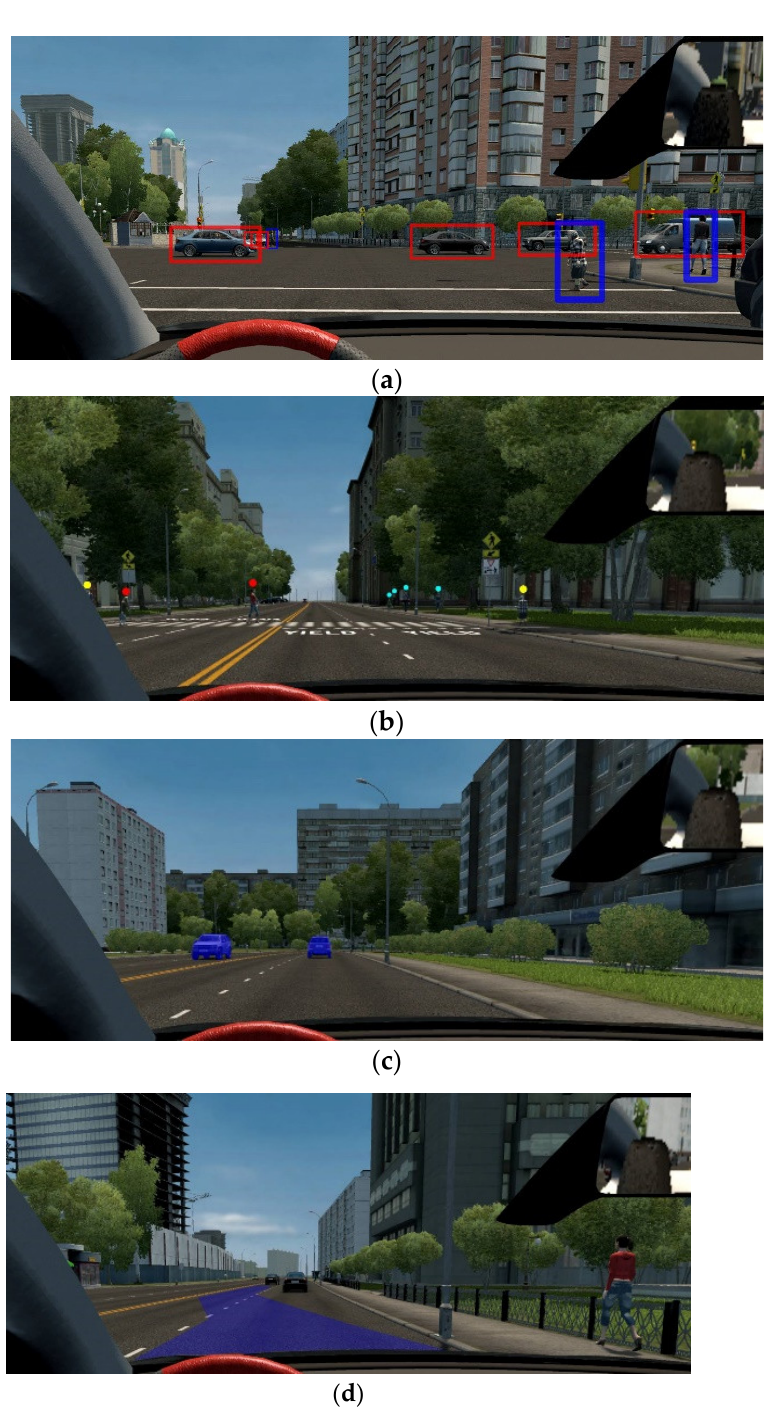
Figure 4: Example illustrations of four different windshield AR interface variations. ( a ) illustrates bounding boxes around pedestrians (blue) and vehicles (red). ( b ) illustrates color coded icons above pedestrians with three levels: pedestrian recognized (cyan), pedestrian intent to cross unclear (yellow), pedestrian crossing (red). ( c ) illustrates highlighting vehicles in blue. ( d ) illustrates a transparent blue lane trajectory indicating the vehicle’s intended route due to a vehicle collision ahead.